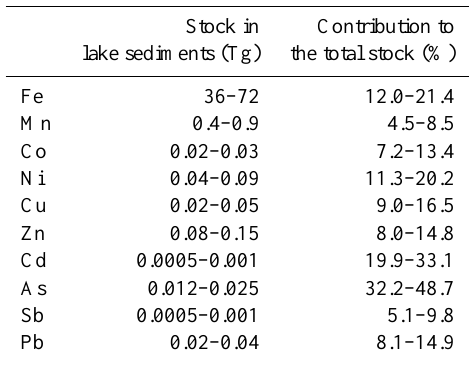
Table 5. Estimated stocks of trace metals and metalloids in lake sediments and their contribution to the total stocks of the Northern part of the Western Siberia peatlands. See text for the calculation